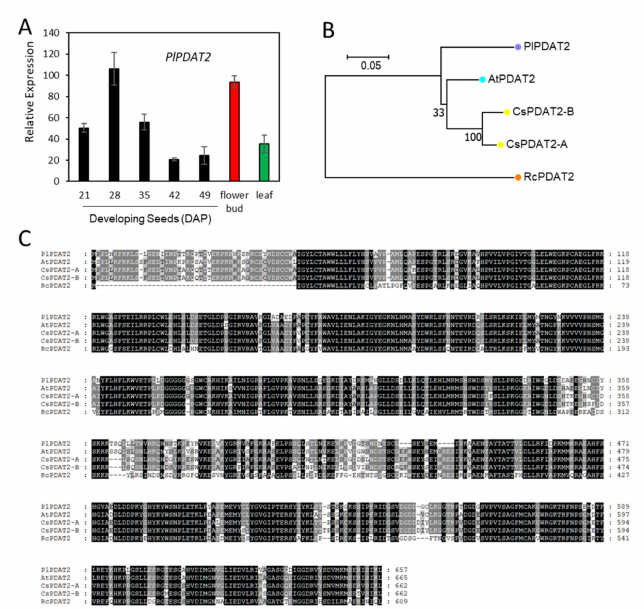
Figure 12. Characterization of PDAT2s in various species. ( A ) Relative expression level of PlPDAT2 in the developing seed, flower, and leaf tissue by qRT-PCR. DAP; day after pollination. ( B ) Phylogenetic tree of PDAT2 proteins from Physaria lindheimeri (PI), Arabidopsis thaliana (At), Camelina sativa (Cs), Ricinus communis (Rc). ( C ) Protein sequences alignment of PDAT2s. Genbank accession numbers are listed in Supplementary File 6, Table S17.